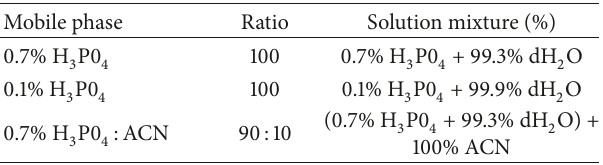
Table 1: Selection of mobile phases for separation of mixed standard, L-citrulline, and L-arginine by isocratic